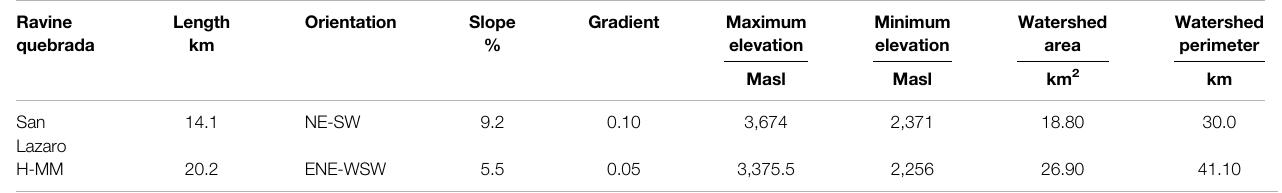
TABLE 2 | Morphometric parameters of the catchments of Qda. San Lazaro and Qda. Huarangal-MM. Ravine